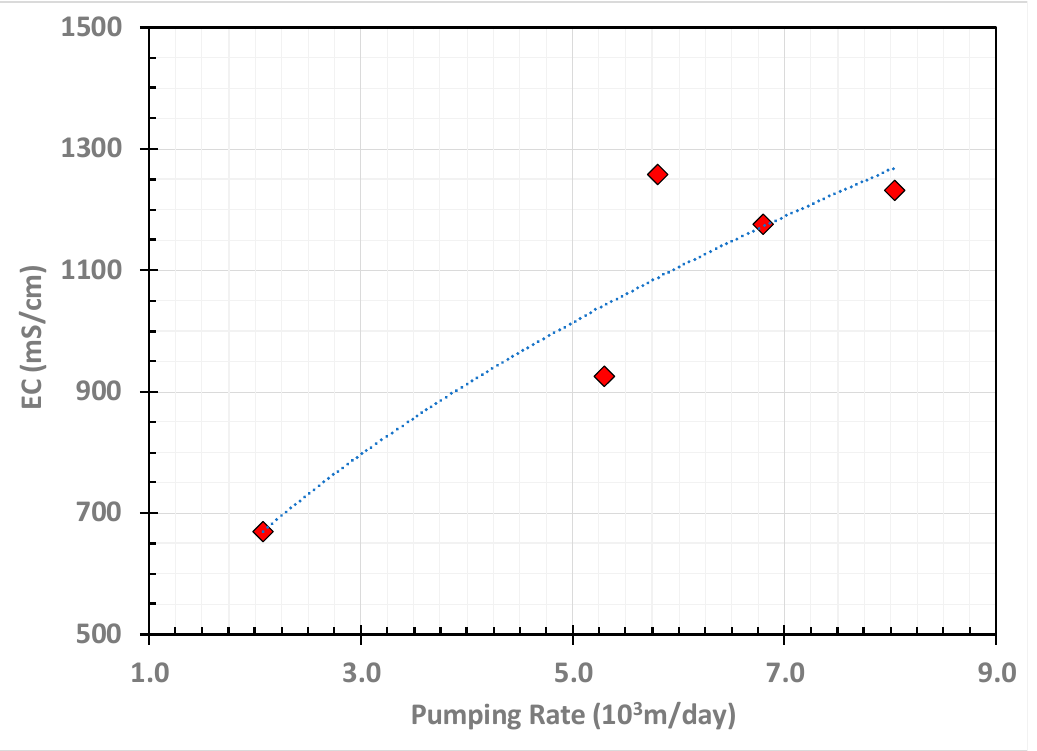
Figure 3. Impact of pumping rate from the Mataki’eua-Tongamai wellfield on the EC of water pumping from an individual well (PS106) between 1971 and 2007 [27].